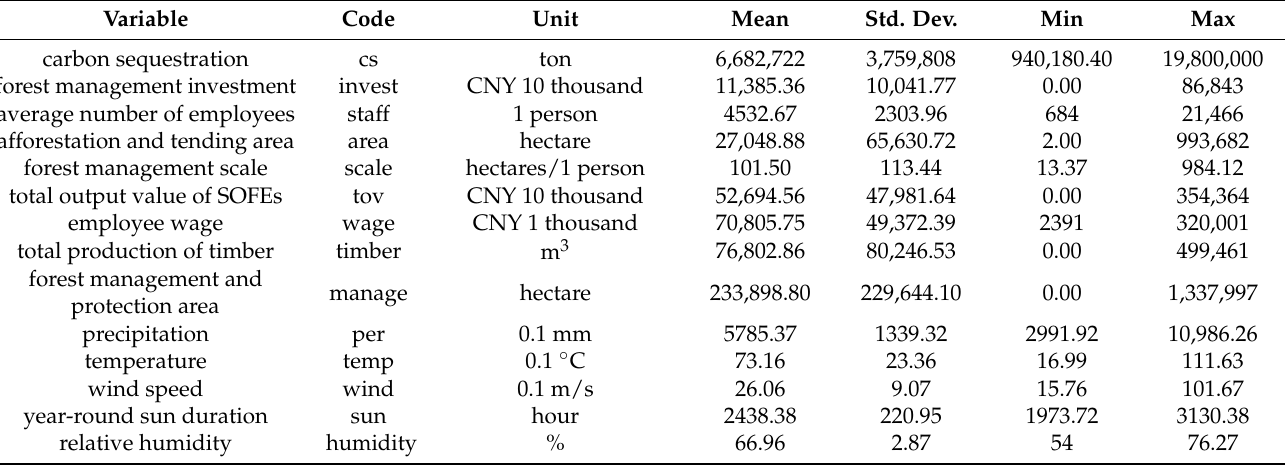
Table 1. Variable design and descriptive